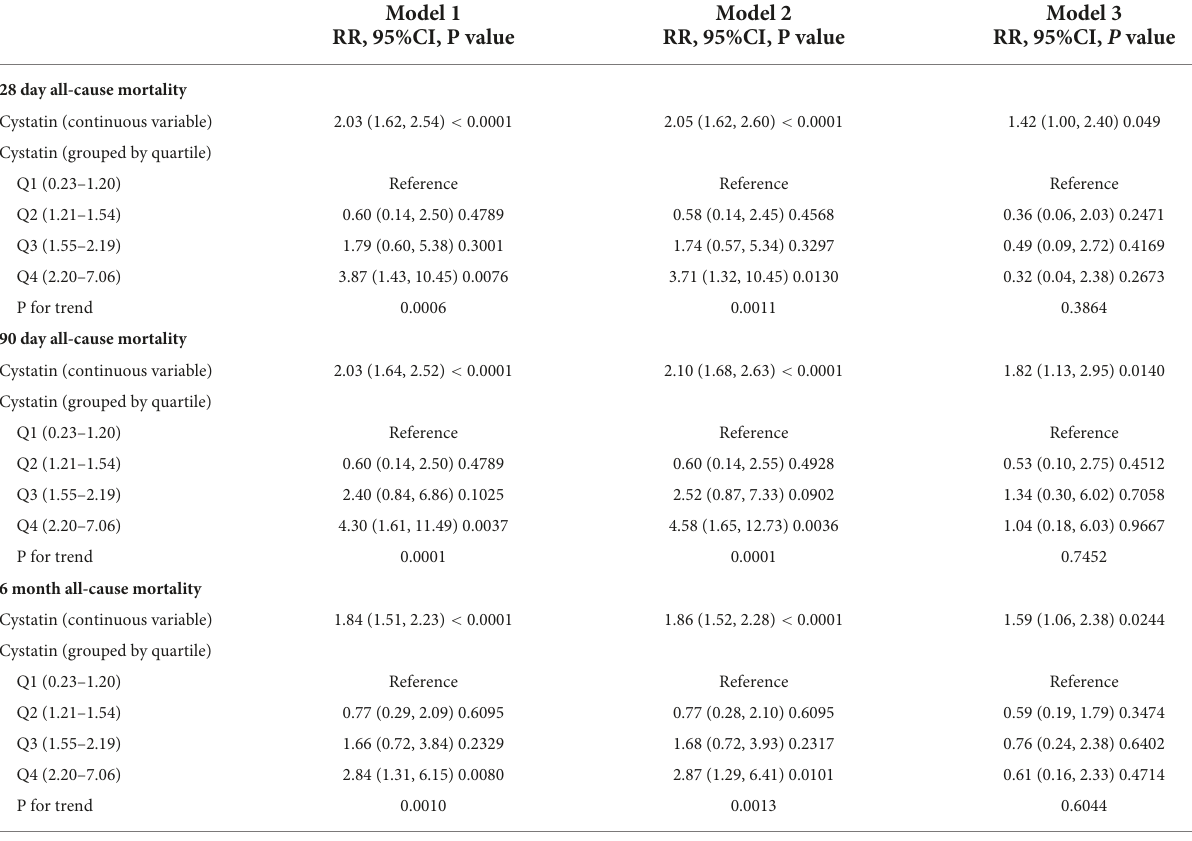
TABLE 2 The association between cystatin and all-cause mortality using univariate and multivariable binary logistic regression model.